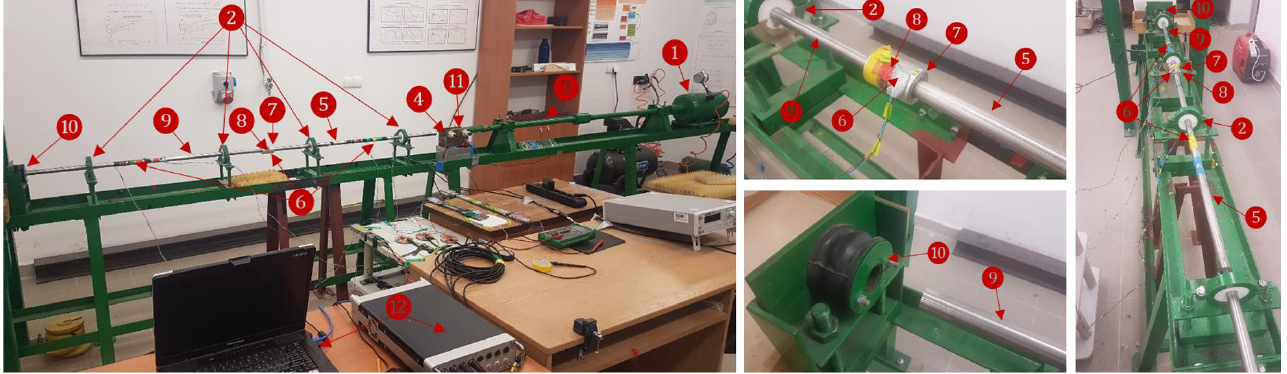
7 of 23 Figure 5. SHPB test stand diagram with designations of important components ❶ – ⓬ (reprinted from Ref. [50]). The following components of the SHPB test stand can be distinguished as important due to the specifics of the dynamic experiment methodology: ❶ — pneumatic bar projectile launcher [51]; ❷ — design to ensure that the bars are axially aligned with each other; ❸ — bar projectile guide (launcher barrel); ❹ — bar projectile; ❺ — initiating bar; ❻ — set of measuring strain gauges;